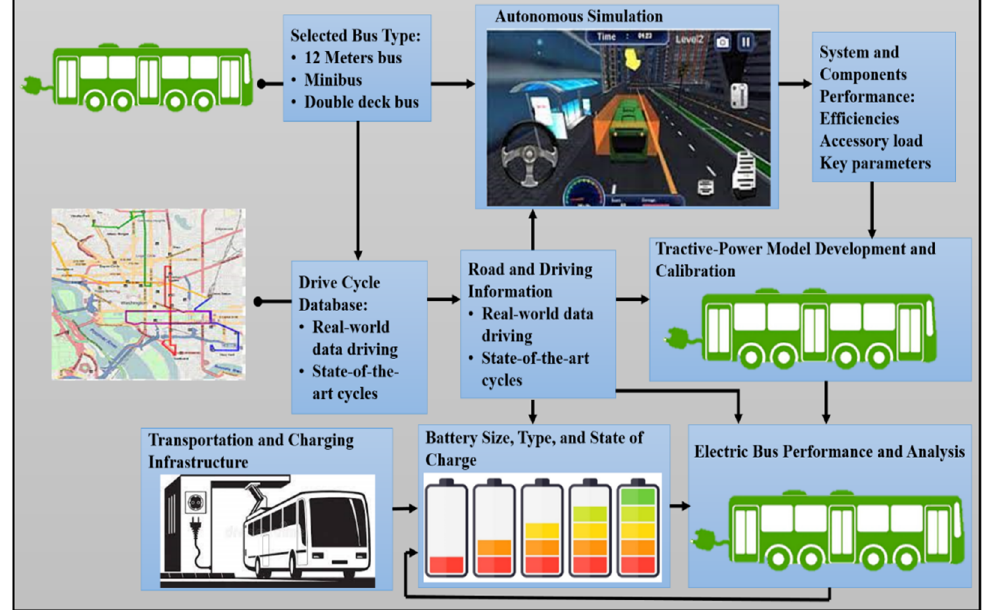
Figure 5. The framework tool for bus electrification feasibility based on actual prototype [18].